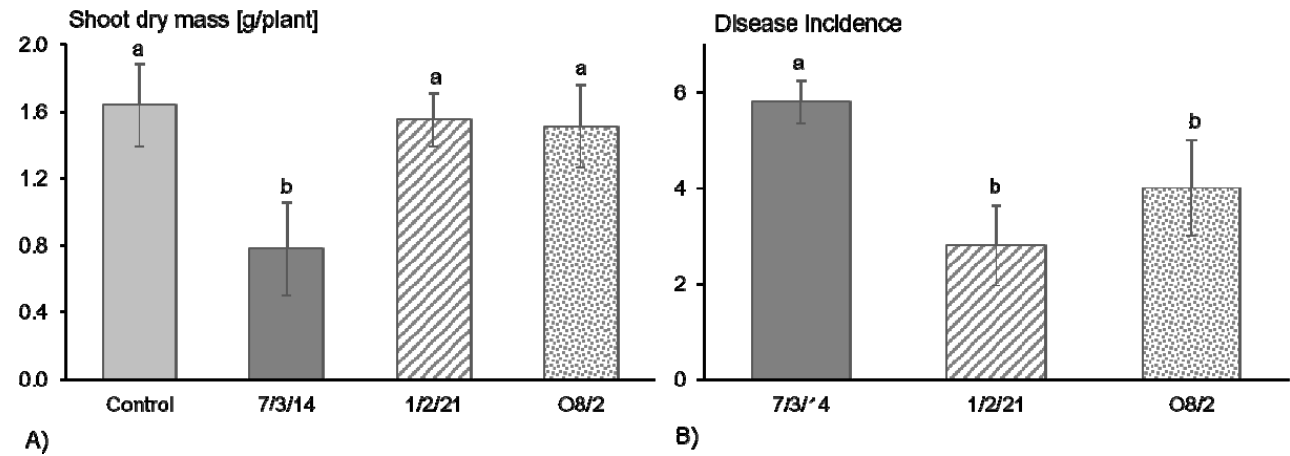
Figure 1. ( A ) Effect of different Rhizoctonia solani AG1-IB isolates (7/3/14, 1/2/21, O8/2) on lettuce growth (cv. Tizian) and ( B ) on disease incidence four weeks after pathogen inoculation and cultivation under controlled conditions. Different letters indicate significant differences between treatments according to the least significant difference (LSD) test ( p ≤ 0.05).